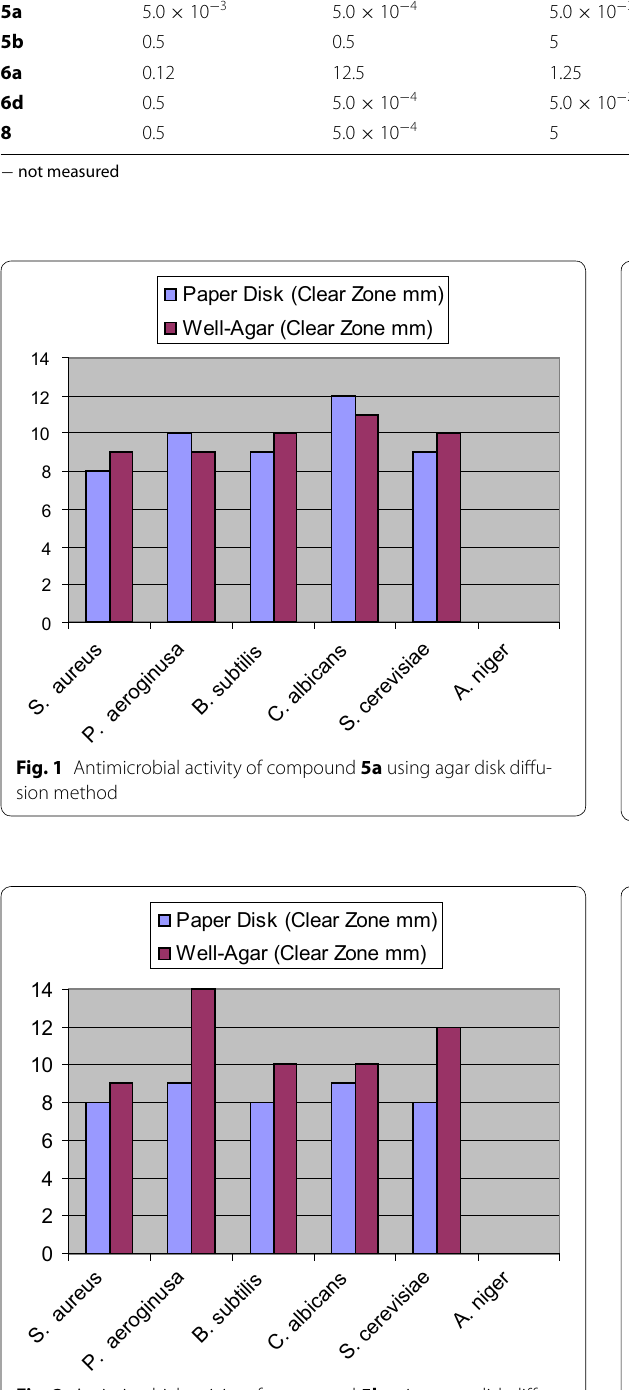
Fig. 4 Antimicrobial activity of compound 6d using agar disk diffu‑ sion